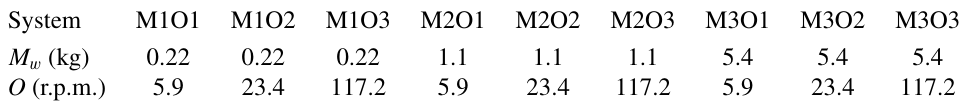
Table 1. The flow systems driven with di ff erent top loads, M w , and base rotating rates, O .